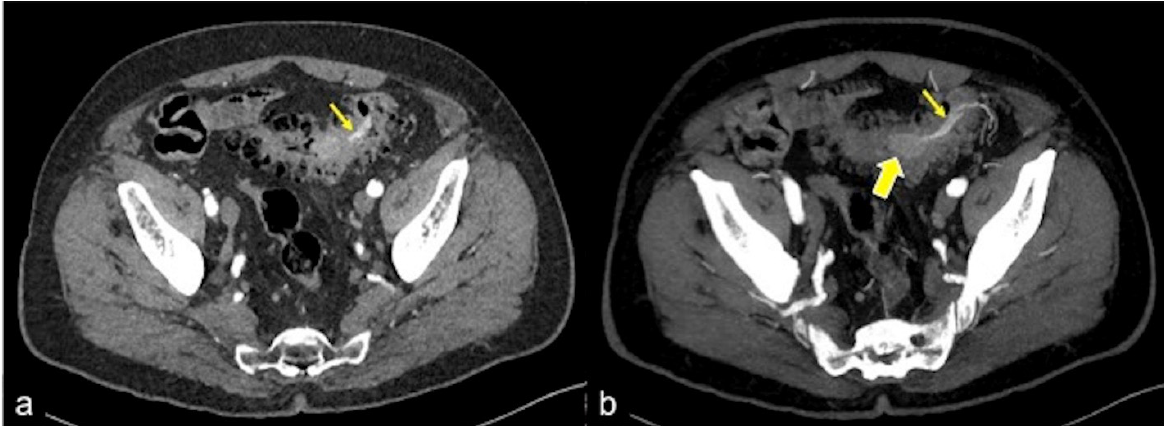
Figure 35. DECTA study of rectal varices. In the venous phase ( a ) and relative iodinated map ( b ), it is possible to identify venous ectasic structures in the rectal wall ( a , b , arrow).